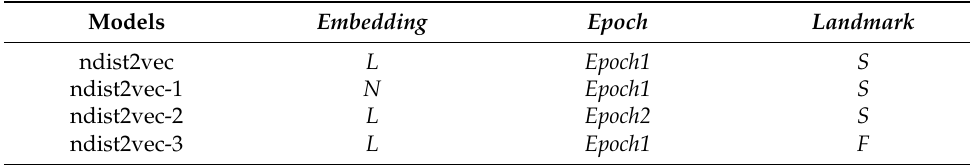
Table 3. Model settings.